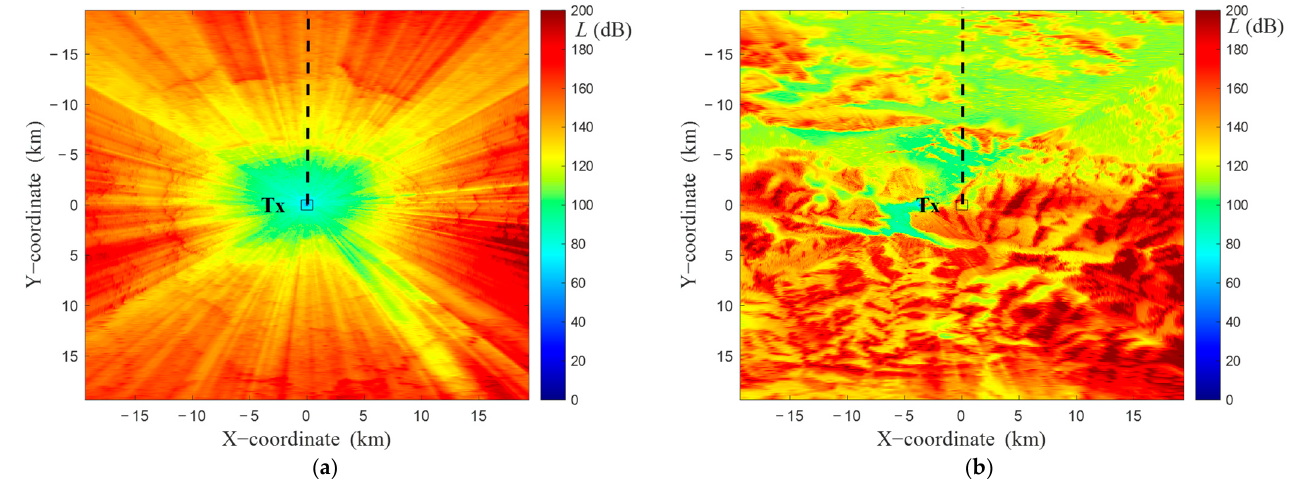
Figure 6. PAMs for two selected Tx locations in ( a ) lowland and ( b ) hilly areas.